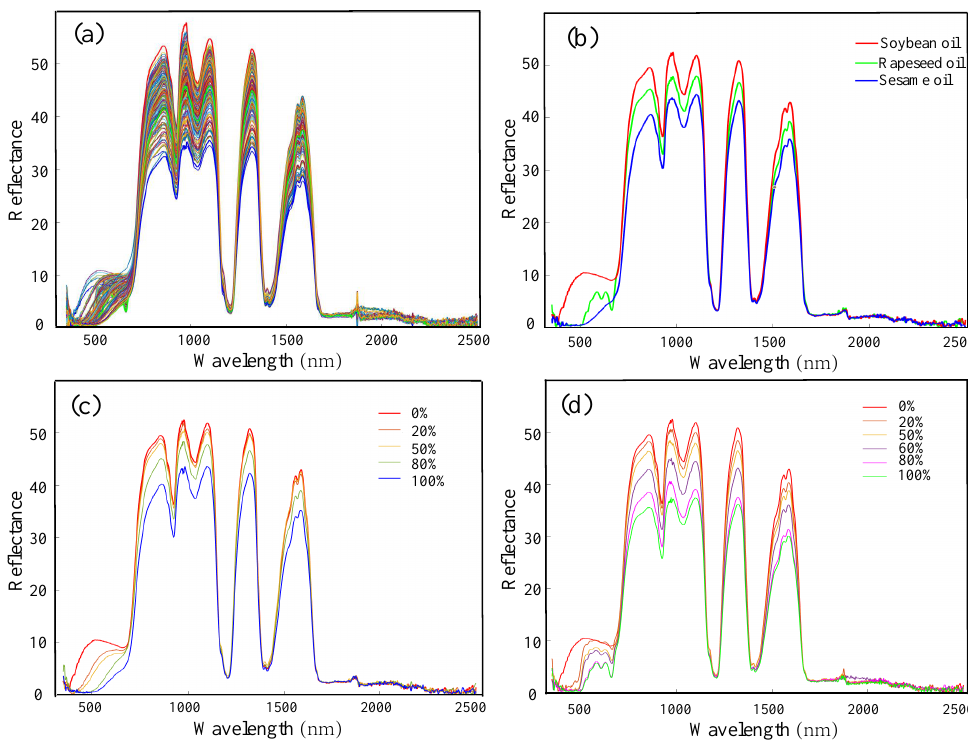
Figure 3. The Vis-NIR reflectance spectra of the adulterated oils and pure oils. ( a ) The overview of all the spectra; ( b ) spectra of pure sesame oil, rapeseed oil, and soybean oil; ( c ) spectra of sesame oil adulterated with soybean oil in different ratios; and ( d ) spectra of rapeseed oil adulterated with soybean oil in different